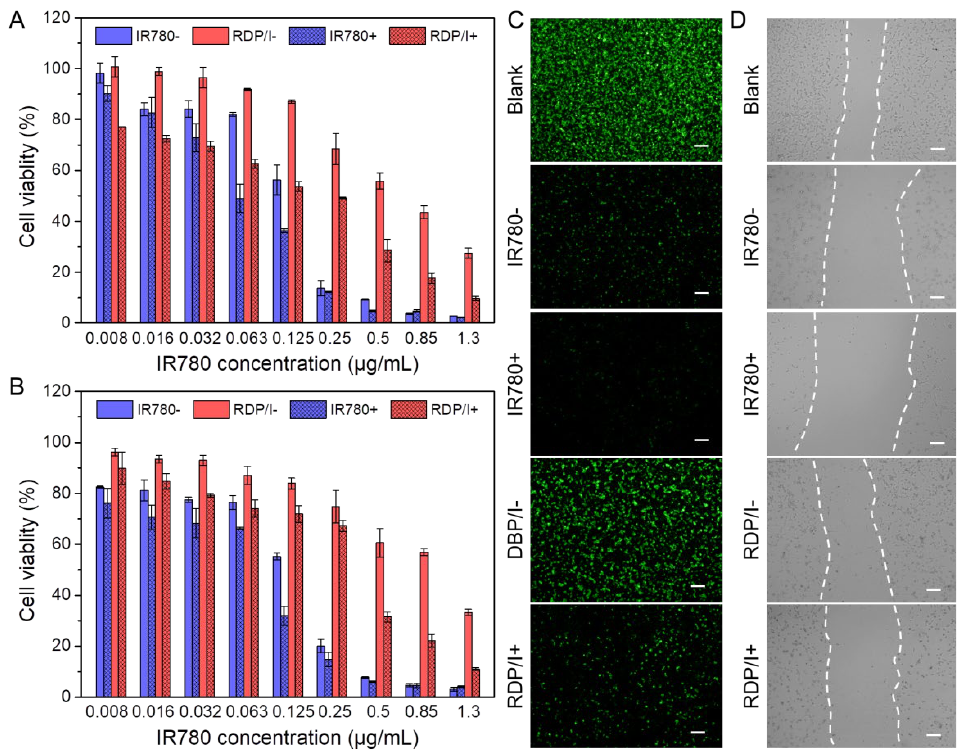
Figure 4. In vitro anti-tumor performance of samples. Cytotoxicity of samples against ( A ) CT26 cancer cells and ( B ) NIH3T3 normal cells; data are shown as mean ± SD (n = 4); ( C ) fluorescent images of sample treated CT26 cells stained with Calcein AM; ( D ) wound healing assay of sample treated CT26 cells; the scale bar: 50 μm.